Question: What kind of plot is shown here?
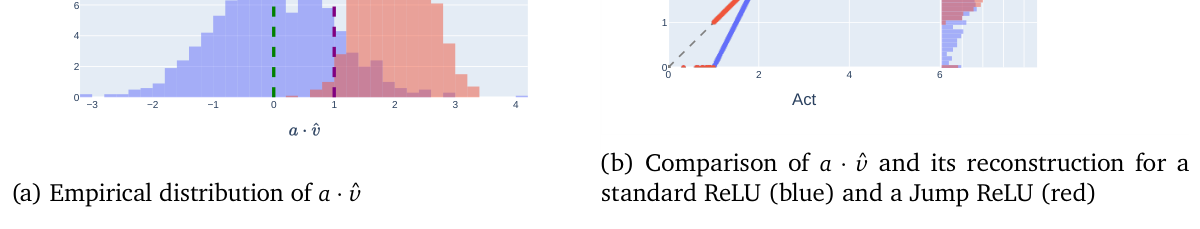
Answer: scatter